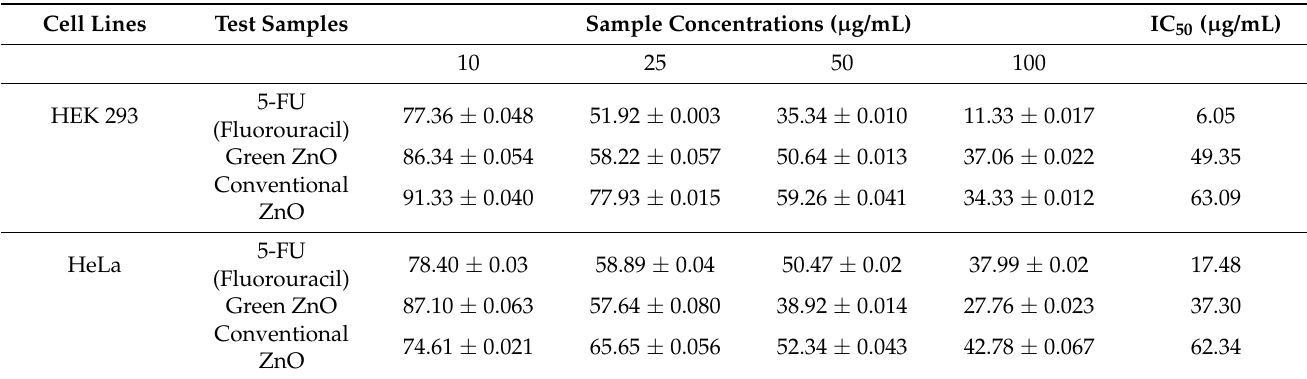
Table 2. Cytotoxic activities (%) of green and conventional ZnO-NPs.